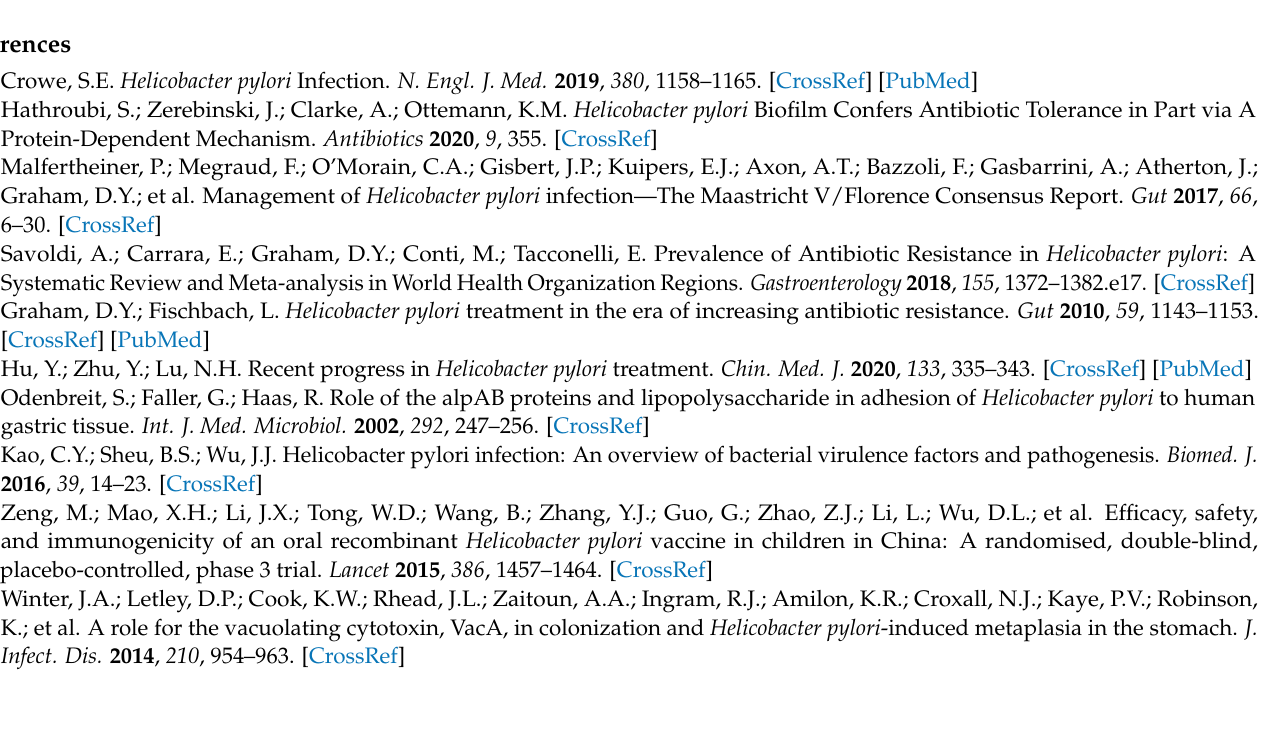
Supplementary Figure S3: Auto-aggregation ability of probiotic strains LN12, LN66, and LN19, Supplementary Figure S4: Hydrophobicity ability of probiotic strains LN12, LN66, and